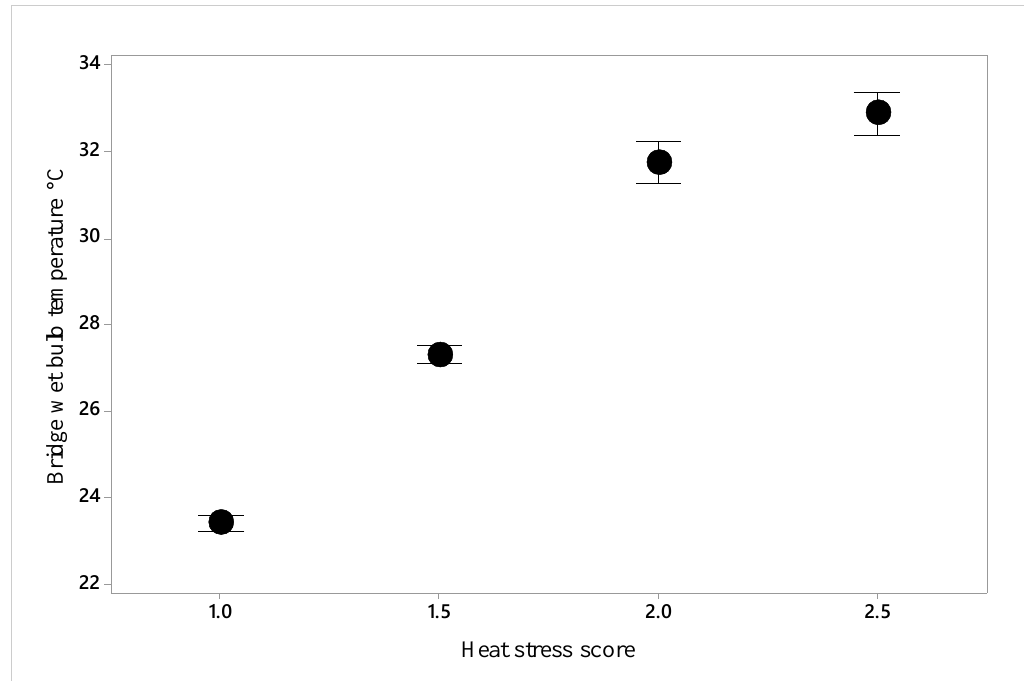
Figure 16. The relationship between bridge T WB and heat stress score (1 = normal, 2 = moderate and 3 = severe) ( n = 3023).